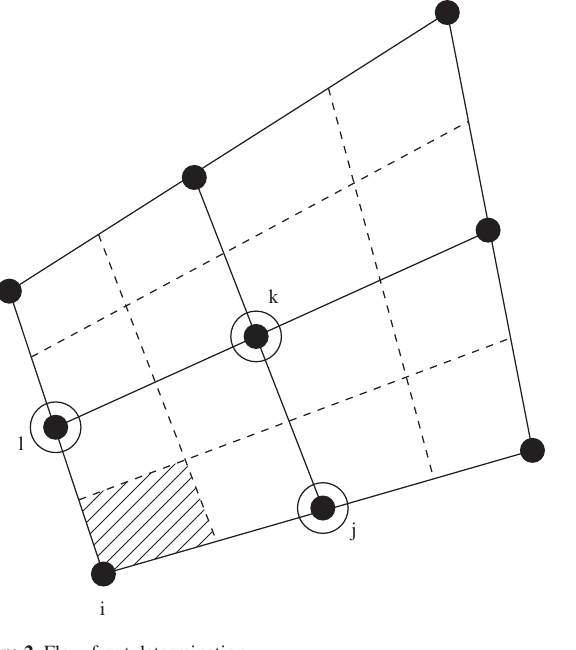
Figure 2. Flow-front determination.